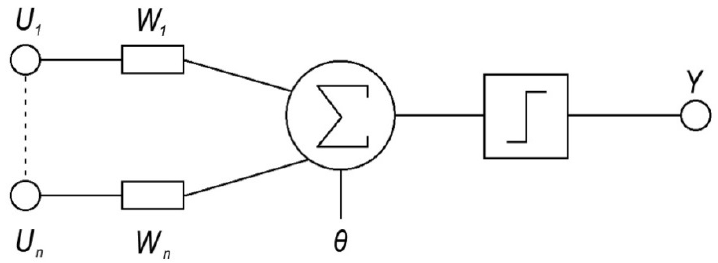
Figure 10. Perceptron design: U 1 , U n —input values, W 1 , W n —perceptron input weights, θ —bias, Y 1 —output value.